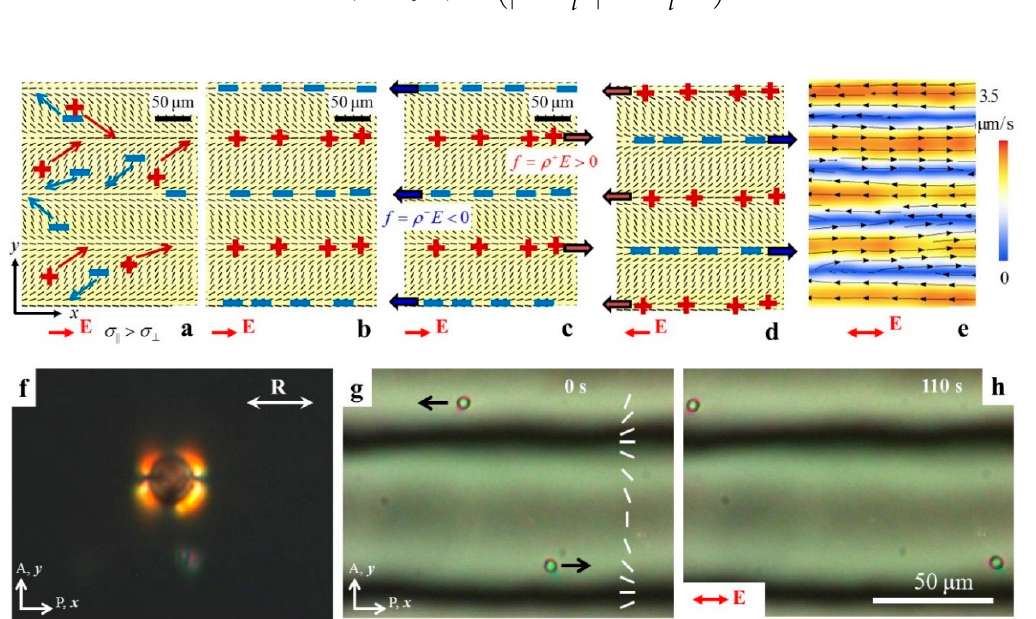
Figure 9. LCEO in an LC electrolyte with a predesigned director. Ticks represent local director visualized by LC PolScope: ( a ) An electric field E drives “+” and “ − “ electric charges along the x -axis but because of the anisotropic conductivity, the charges shift also along the y -axis, ( b ) Creating separated lanes of space charges; ( c ) The electric field moves the charged clouds along the x -axis; ( d ) Reversal of the field changes polarity of charges but does not change the Coulomb force; ( e ) An AC field of frequency 5 Hz creates lanes of LCEO flows of alternating direction; ( f ) Polarizing microscopy texture of a polystyrene sphere with tangential anchoring and bipolar director field; ( g,h ) Time sequence of AC-driven LCEO flows carrying polystyrene spheres with tangential surface anchoring. Parts ( a – e ) and ( g , h ) are adapted with permission from Peng et al. [26] .